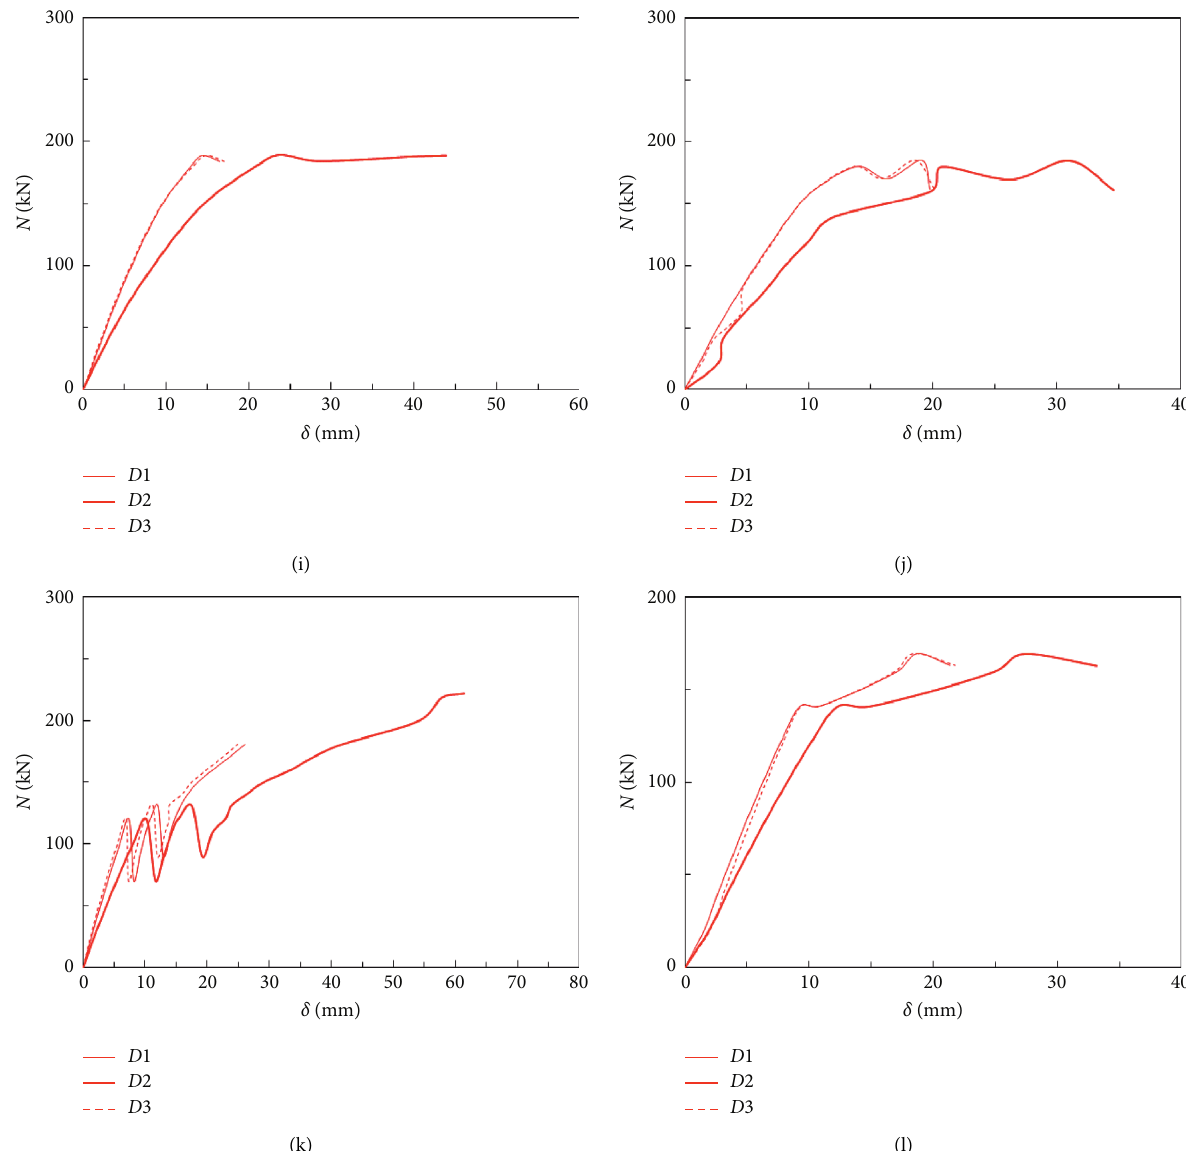
Figure 9: Load-vertical displacement curves. (a) PB-2. (b) FLB-1-S1. (c) FLB-1-S2. (d) FLB-2-F0. (e) FLB-2-F1. (f) FLB-2-F2. (g) EPB-1-N.